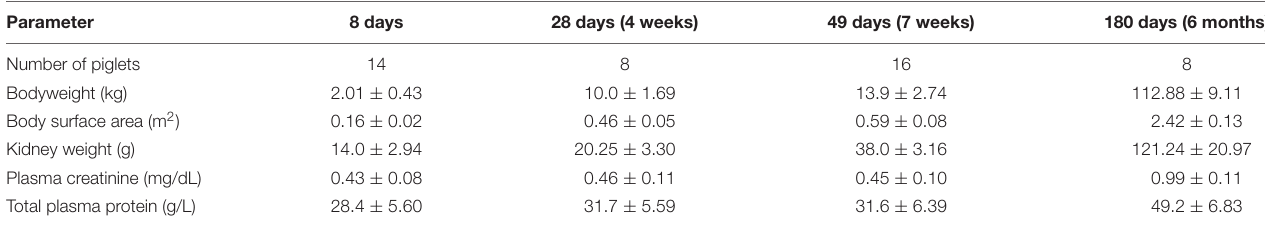
TABLE 1 | Descriptive statistics of the piglet study population. Values are mean ± SD. Parameter